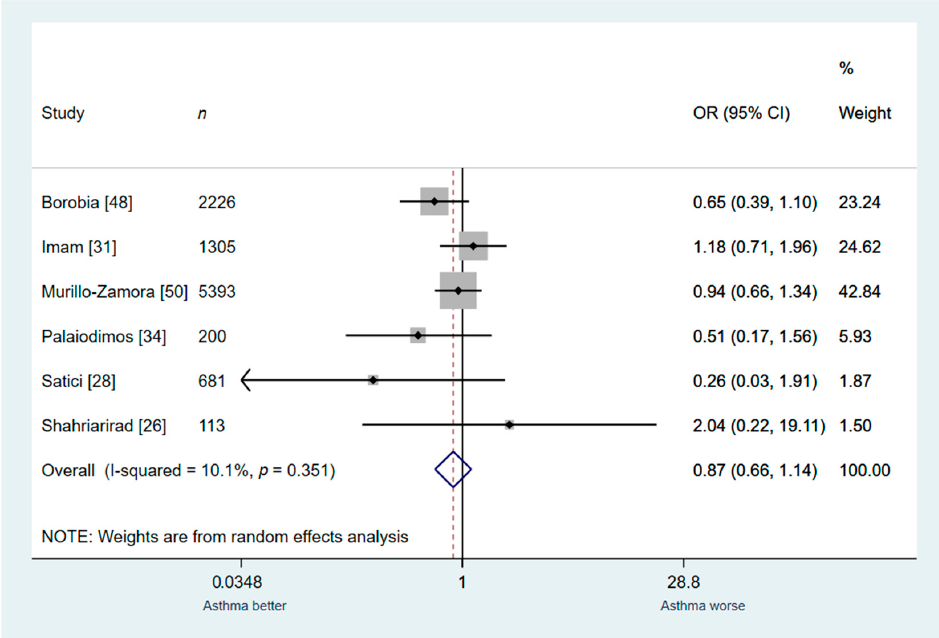
Figure 8. Analysis of the studies that included only general patient population: asthma vs. no asthma for in ‐ hospital mortality.